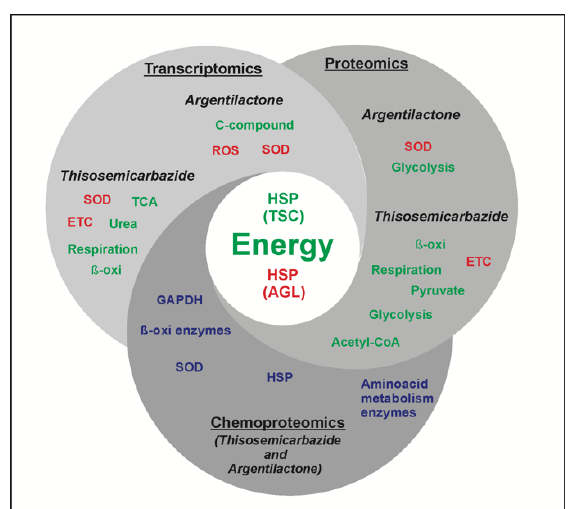
Figure 3. Modes of action of argentilactone and camphene thiosemicarbazide in Paracoccidioides . The diagram shows the two natural compounds that have been tested in Paracoccidioides cells according to three different ohmic approaches (proteomics, transcriptomics, and chemoproteomics). The central circle shows the common ways both compounds act in the pathogen; both restrict the ability of cells to produce energy through several pathways and, regarding stress conditions, the difference is that while thiosemicarbazide leads to a reduced HSP levels, argentilactone acts in such a way that protein/gene levels are increased. The green color indicates downregulation and the red color indicates upregulation. SOD—superoxide dismutase; ROS—reactive oxygen species; TCA— tricarboxylic